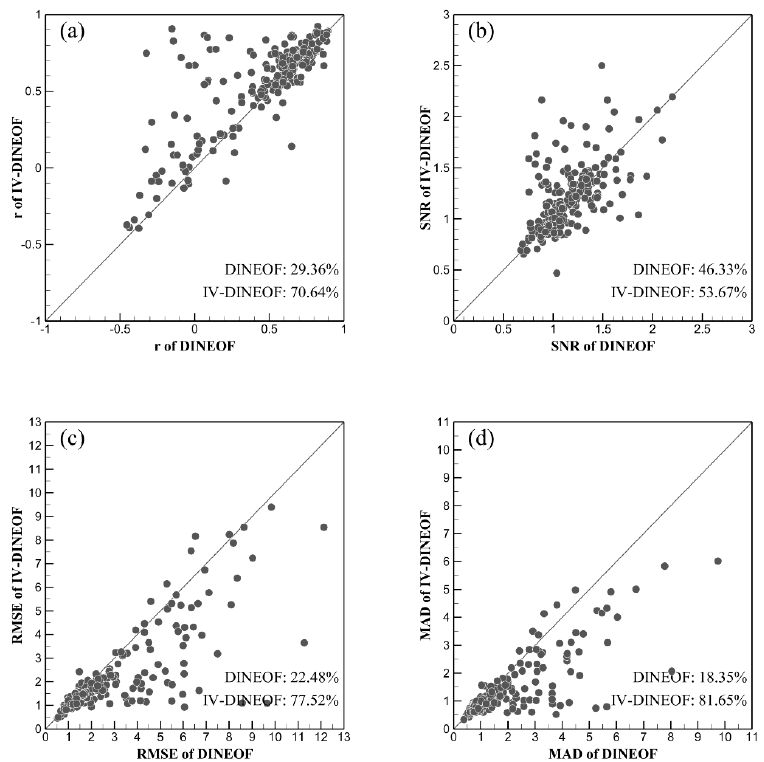
Figure 6. Comparison of results of every single month between DINEOF and IV − DINEOF: ( a ) correlation coefficient, ( b ) signal-to-noise ratio, ( c ) root mean square error, and ( d ) mean absolute difference.